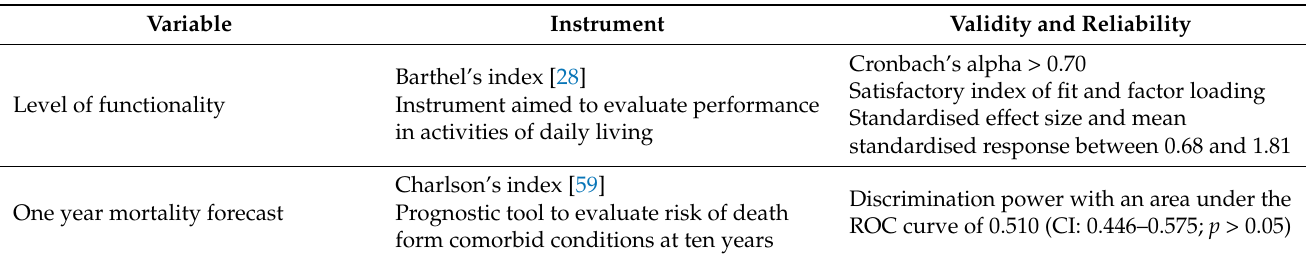
Table 1. Validity and reliability of the instruments